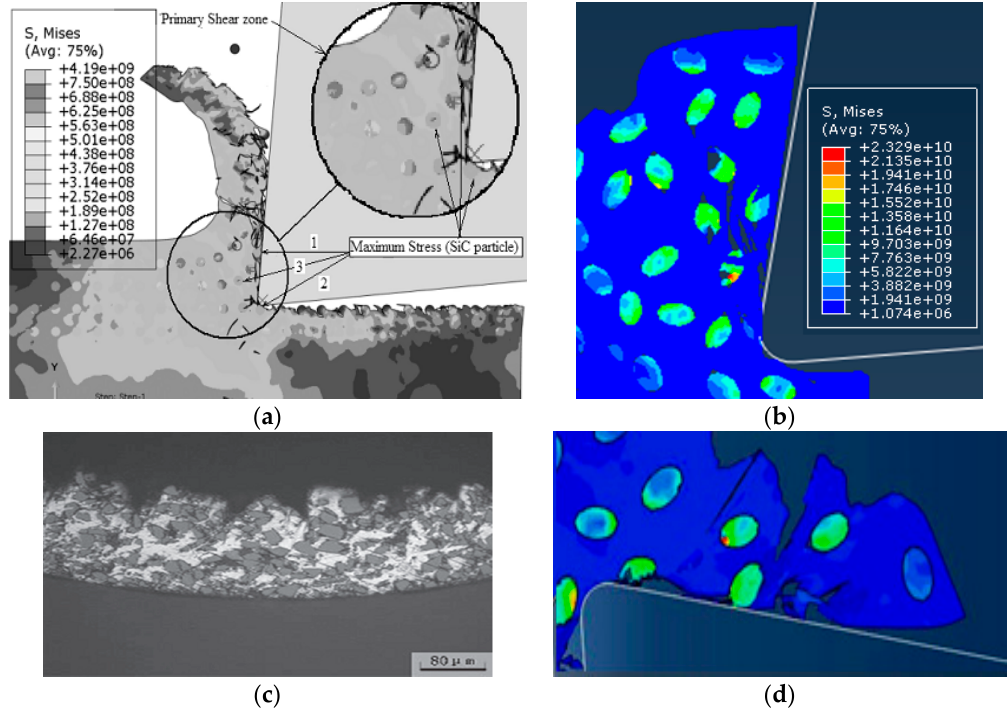
Figure 31. Comparison of chip morphology at different particle ratio, cutting speed and feed rate: ( a ) Particle ratio 20 μ m v c = 80 m/min f = 0.24 mm/r. reproduced with permission from ref. [20] Copyright 2013, John Wiley and Sons, ( b ) simulated chip particle ratio 20 μ m v c = 100 m/min f = 0.2 mm/r, ( c ) 30 μ m v c = 120 m/min f = 0.1 mm/r. Adapted with permission from ref. [50] Copyright 2018, Elsevier, ( d ) simulated chip 20 μ m v c = 100 m/min f = 0.1 mm/r.